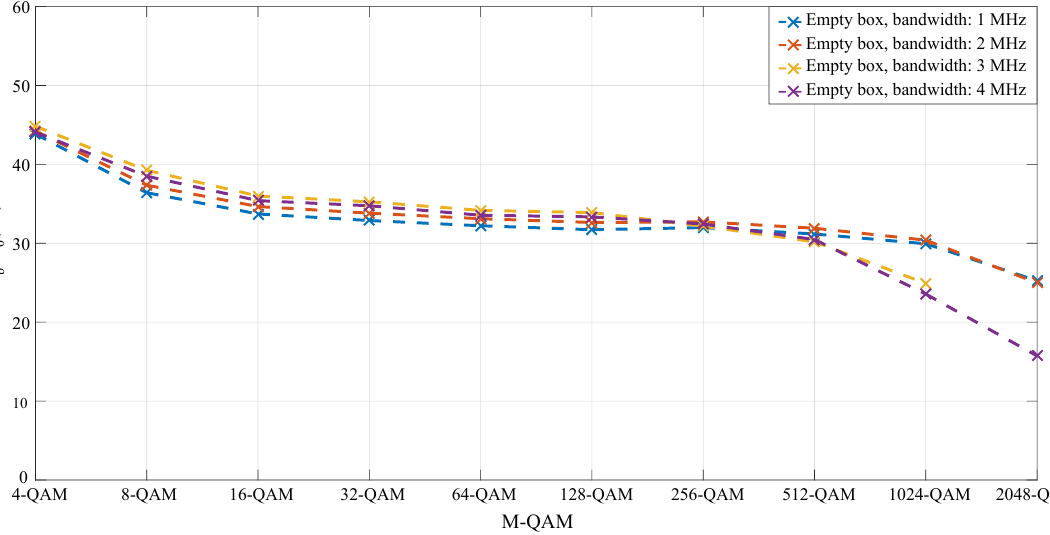
Figure 16. E b /N 0 / distance relationship for Octavia tail-light with different M-QAM and bandwidths —in scenario 1—empty